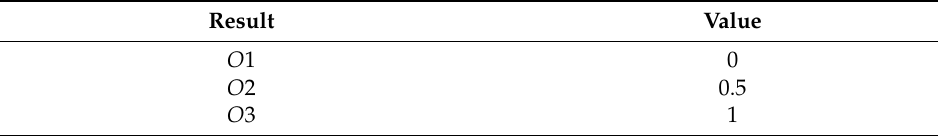
Table 12. The result and value of the healthy state assessment.